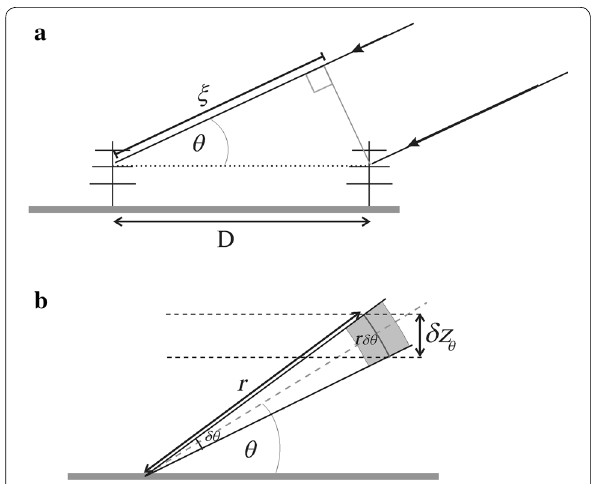
Fig. 3 a A simple 2-antenna interferometer, for illustrative purposes. b Spatial resolution corresponding to an angular resolution